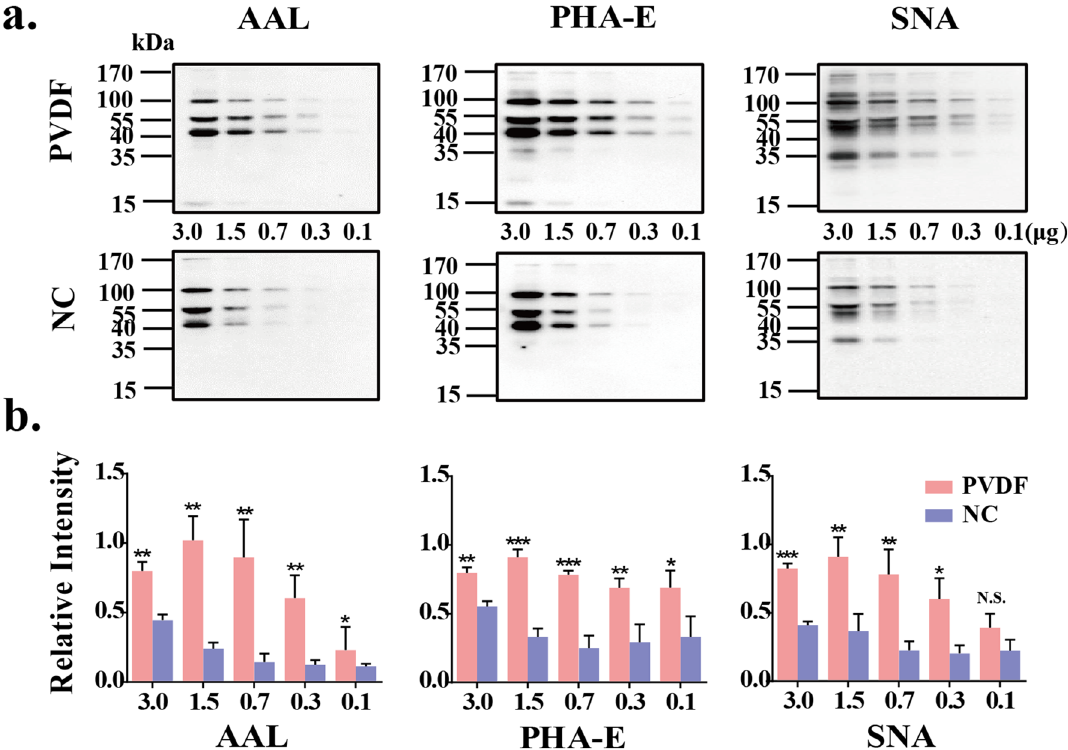
Figure 4. Comparison of the binding ability of PVDF membrane and NC membrane to glycoproteins. ( a ) The mixed sera of healthy samples were diluted by gradient (3.0, 1.5, 0.7, 0.3 and 0.1 μg). Then the sera were separated by 8% SDS-PAGE. The proteins were transferred onto PVDF membranes (up) and NC membrane (down), respectively. The membranes were incubated with AAL, PHA-E and SNA. ( b ) Staining intensities were statistically analyzed (n = 3 individual experiments). Pink bar, PVDF membrane; Blue bar, NC membrane. Band intensities were analyzed and compared using Image Lab software (Bio-Rad Laboratories) and GraphPad Prism version 6. *Significantly different p < 0.05, ** p < 0.01, *** p < 0.001. N.S., not significant. All values are means ± S.E. (error